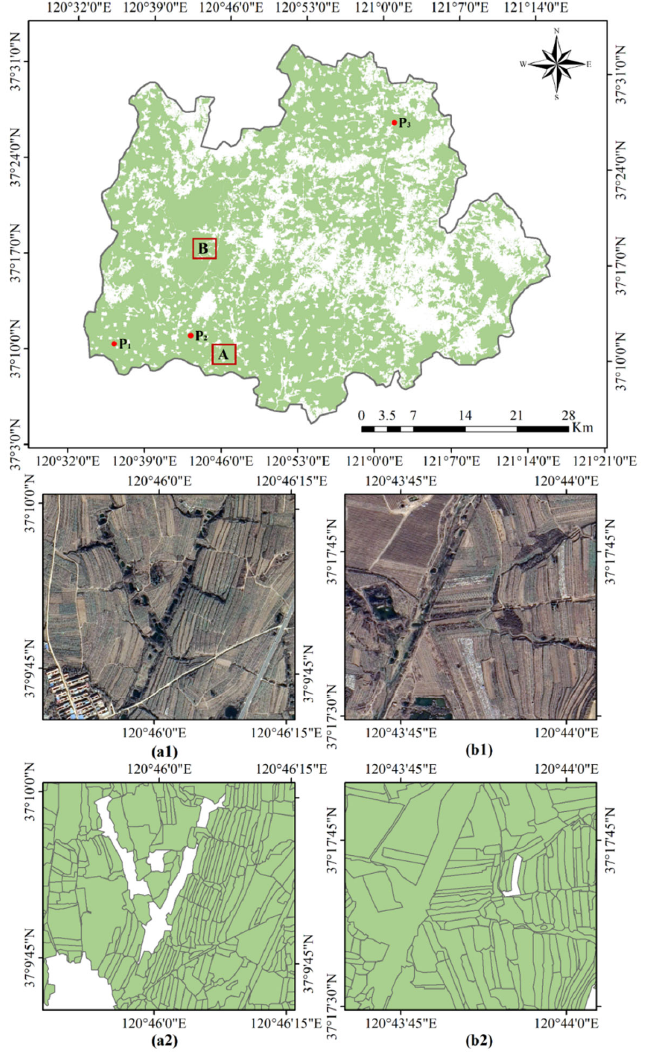
Figure 9. The distribution map of farmland parcels in the study area using the proposed method. (A, B) are sub-regions of the study area.